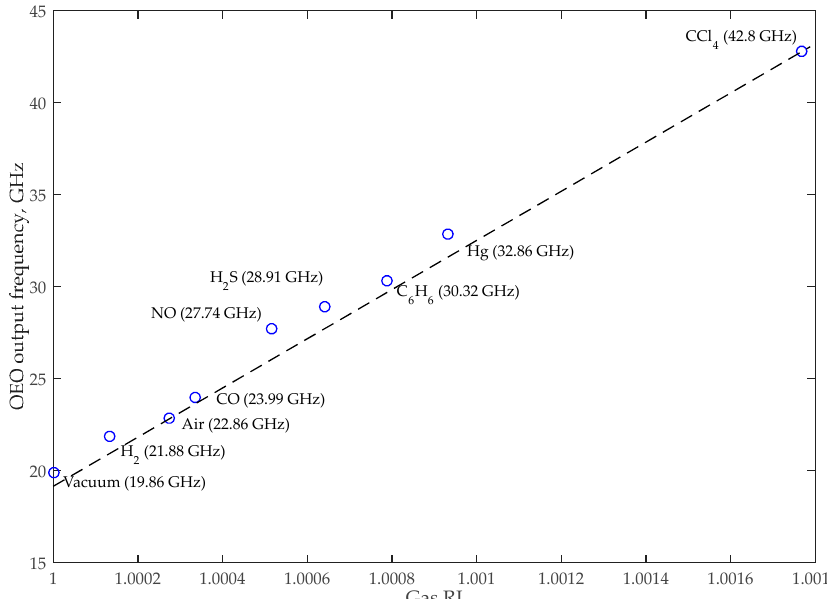
Figure 11. OEO output frequency dependence on gas RI using an SOI-based MRR.